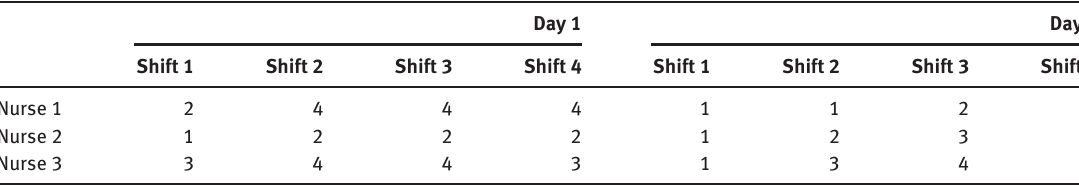
Table 1: An Illustration of Preference Matrix.